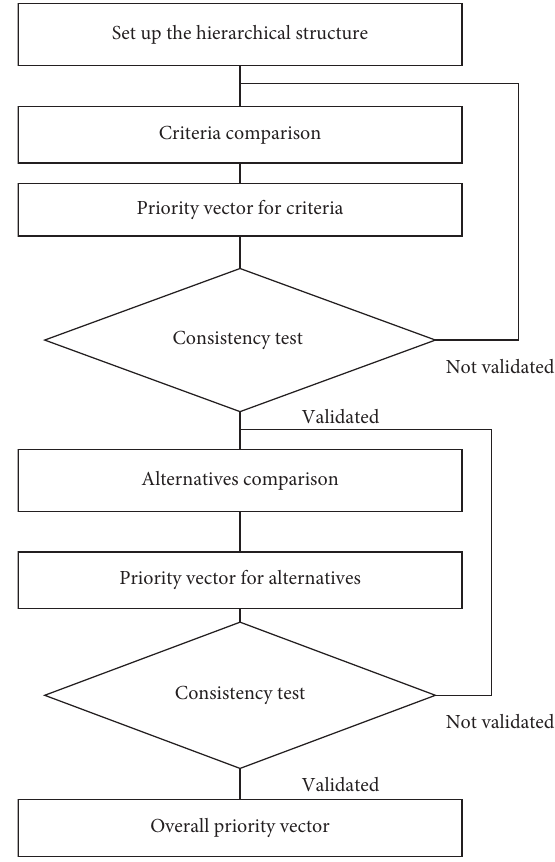
Figure 5: Analytic hierarchy process (AHP) steps.